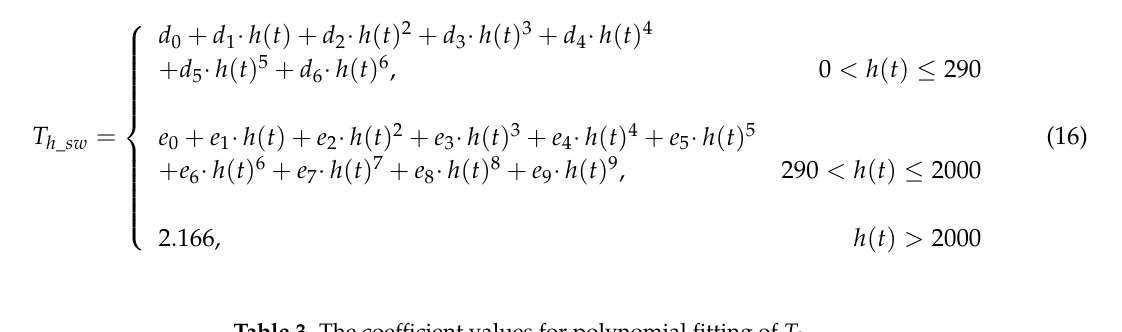
Table 3. The coefficient values for polynomial fitting of T h _ ss .